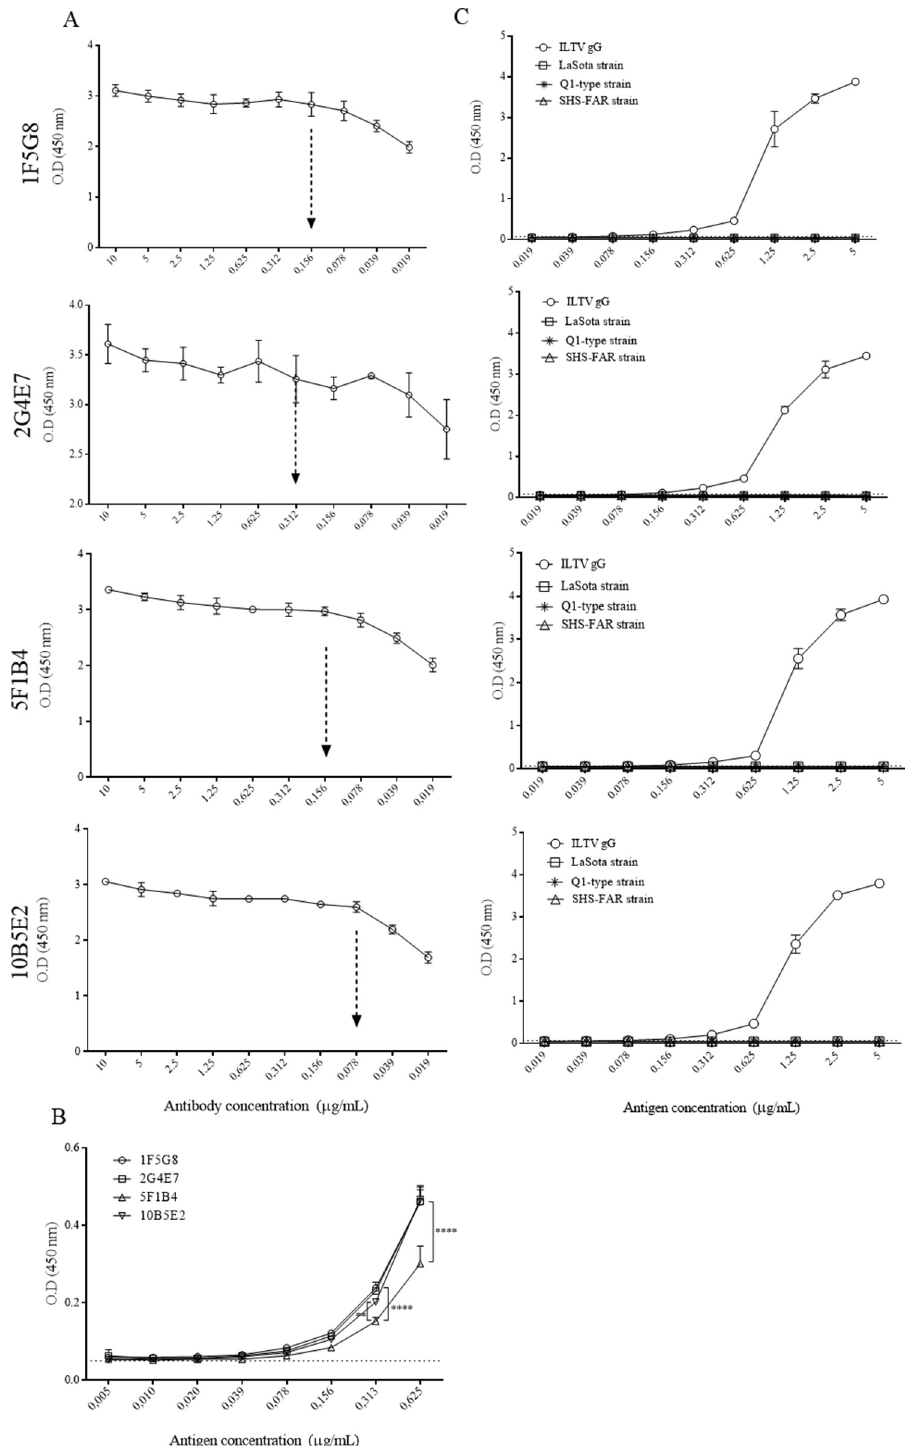
Fig 5. Evaluation of monoclonal antibodies using the ILTV gG recombinant protein in an indirect ELISA assay. A. Determination of the optimal monoclonal antibody concentration for the detection of ILTV gG. B. Limit of detection for each monoclonal antibody. C. Specificity evaluation for monoclonal antibodies using ILTV gG as a positive control and other related chicken respiratory viruses (Newcastle disease virus [LaSota strain], infectious bronchitis virus [Q1-type strain] and avian metapneumovirus [SHS-FAR strain]). Dashed arrows show the optimal antibody concentration. Cutoff = 0.05. Two-way ANOVA and Tukey’s post hoc were performed. �� : p = 0.001. ���� : p < 0.0001. https://doi.org/10.1371/journal.pone.0219475.g005 PLOS ONE | https://doi.org/10.1371/journal.pone.0219475 August 21,